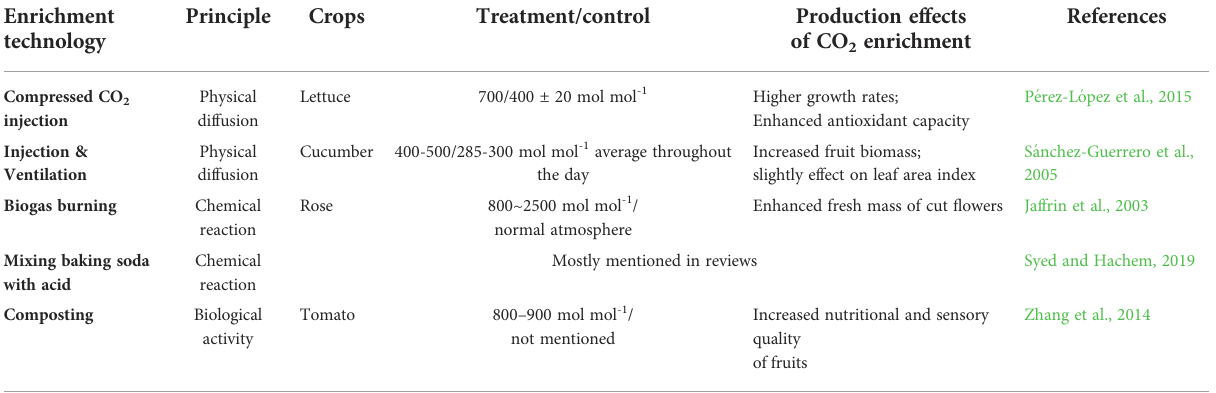
TABLE 1 Application examples of different CO 2 enrichment technologies reported in scienti fi c articles.